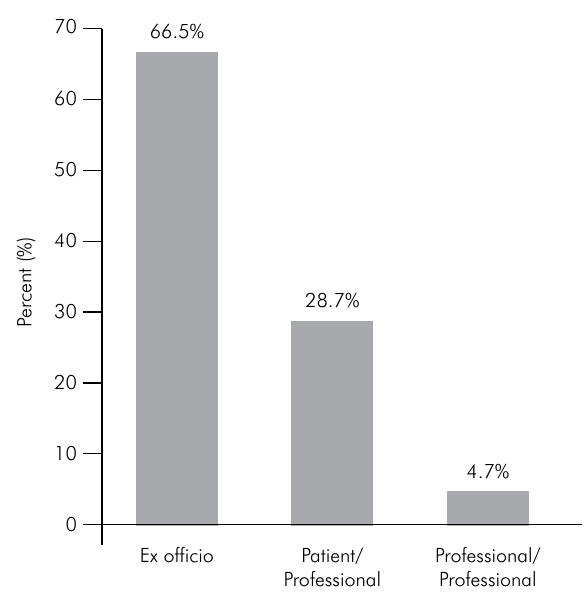
Figure 1. Percent distribution of lawsuits analyzed at the CRO/ES between 2000 and 2010, according to the nature of the accusations. Source: CRO/ES, Vitória,